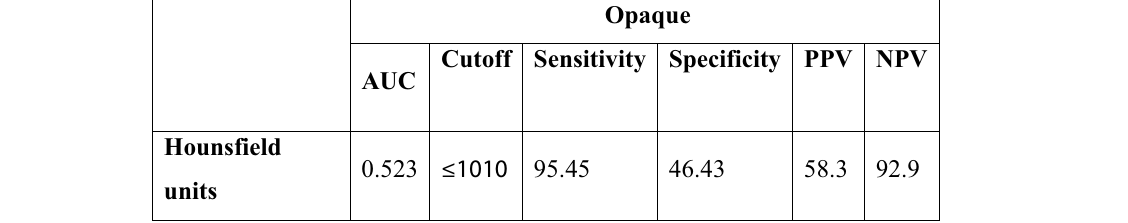
Fig. 2 ROC curve of opaque stone in PKUB regarding its density in Hounsfield